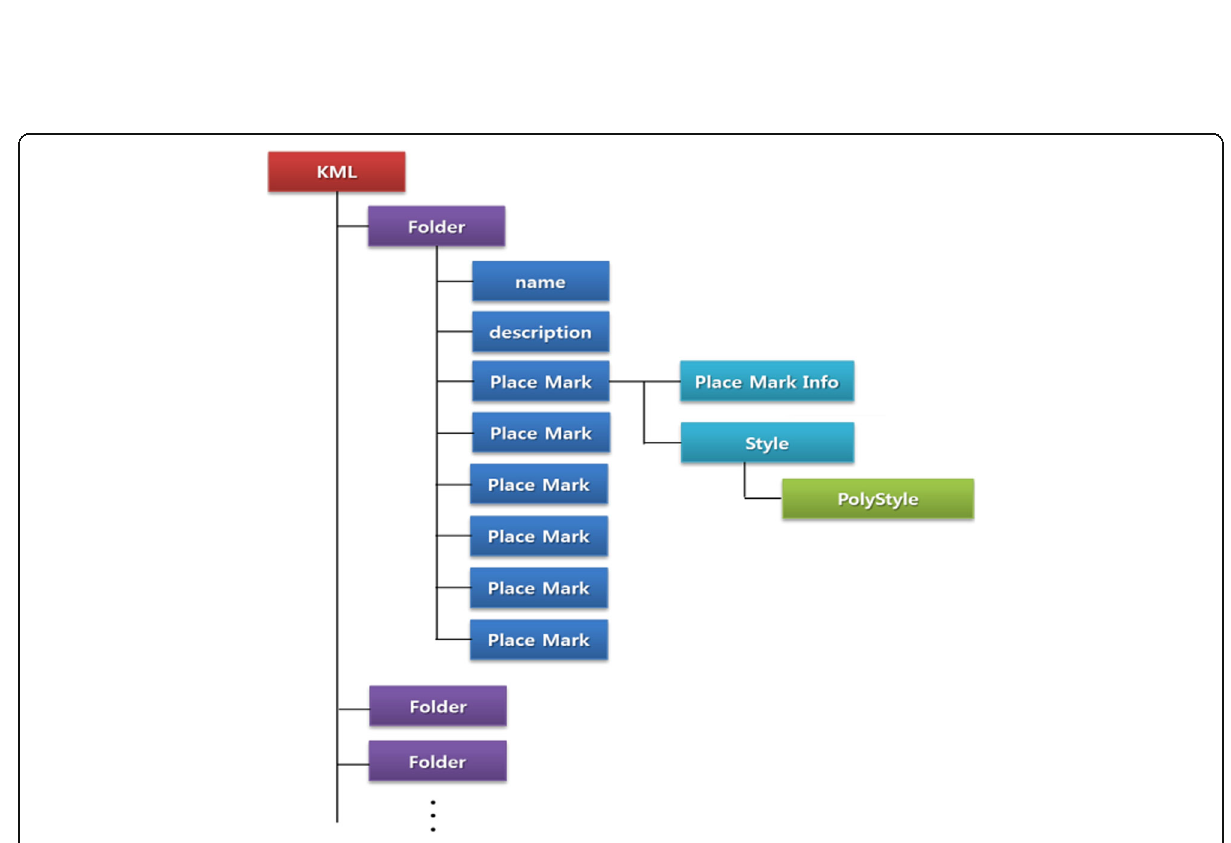
Fig. 5 KML structure for visualization of the pollution level in the observation area